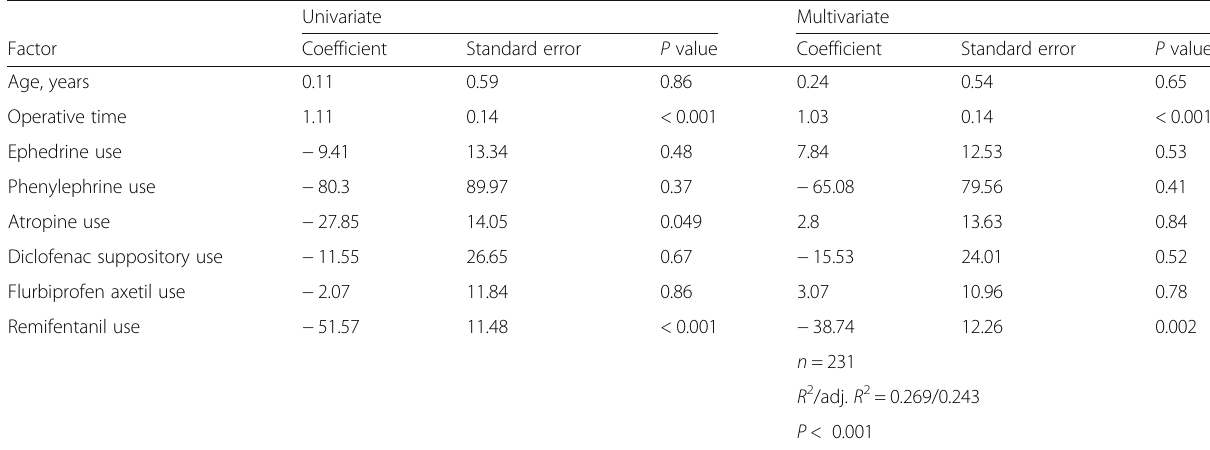
Table 3 Univariate and multivariate linear regression analyses to identify the factors associated with blood loss during partial